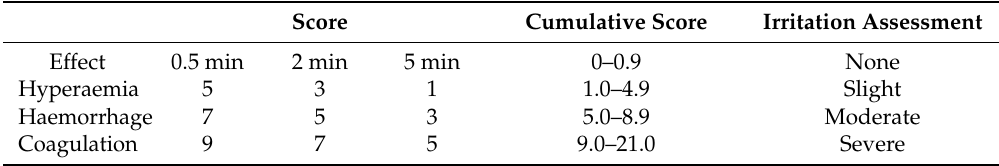
Table 4. Irritation scores and interpretations used in HET-CAM